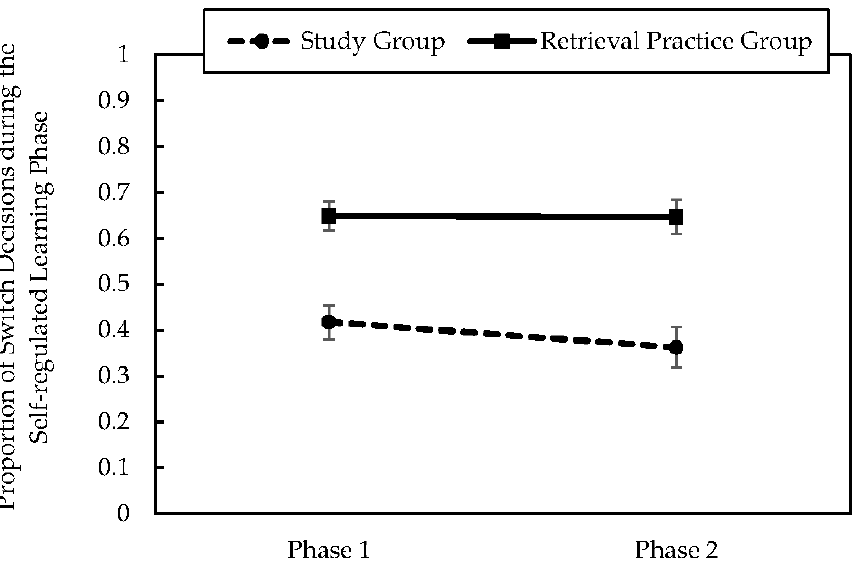
Figure 2. Values represent the mean proportion of switch decisions during each of the self-regulated learning phases for each group. Error bars represent the standard error of the mean.